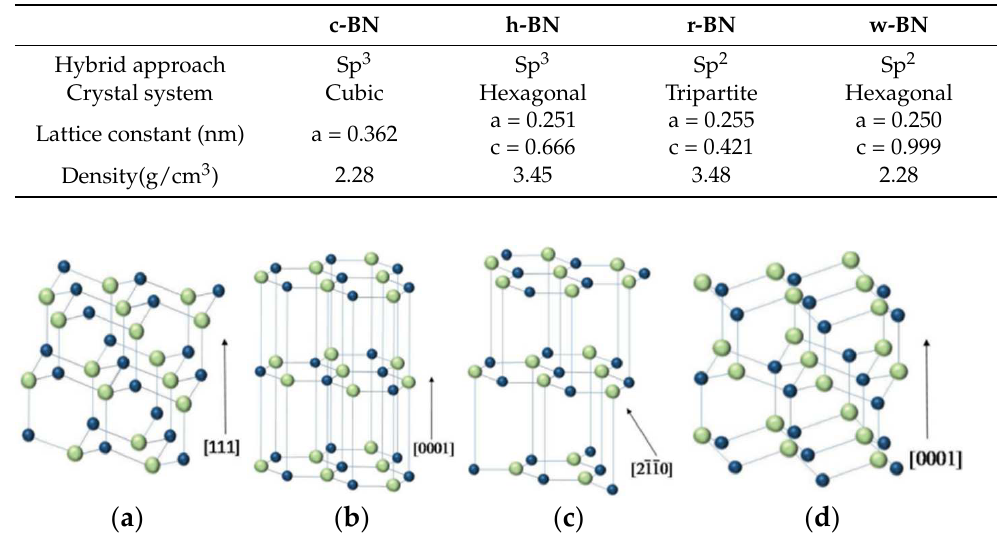
Figure 2. Schematic diagram of the crystal structure of various BN phases [17].; ( a ) c-BN; ( b ) h-BN; ( c ) r-BN; ( d ) w-BN.